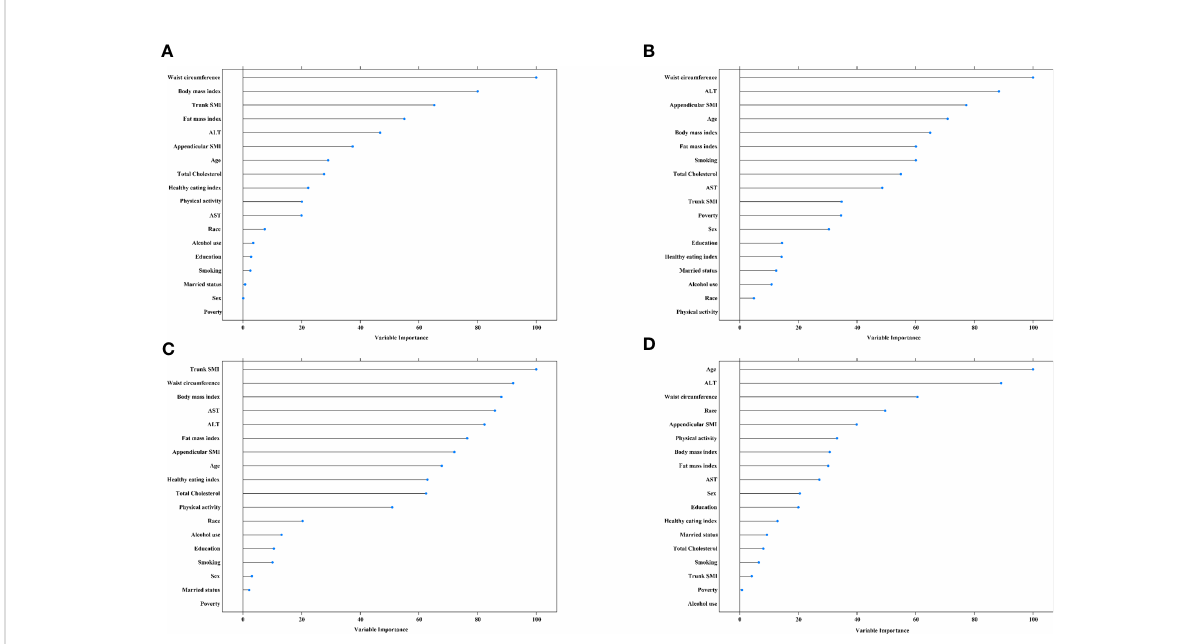
FIGURE 4 Variable importance for predictors of MAFLD and signi fi cant fi brosis (A) , random forest for MAFLD. (B) , logistic regression model for MAFLD. (C) , random forest for signi fi cant fi brosis. (D) , logistic regression model for signi fi cant fi brosis. The predicators included age, race, education, poverty, married status, smoking, alcohol use, health eating index, physical activity, BMI, hypertension, waist circumference, total cholesterol, alanine aminotransferase, and fat mass index. MAFLD, metabolic dysfunction-associated fatty liver disease. SMI, skeletal muscle mass index. ALT, alanine aminotransferase. AST, aspartate transaminase.